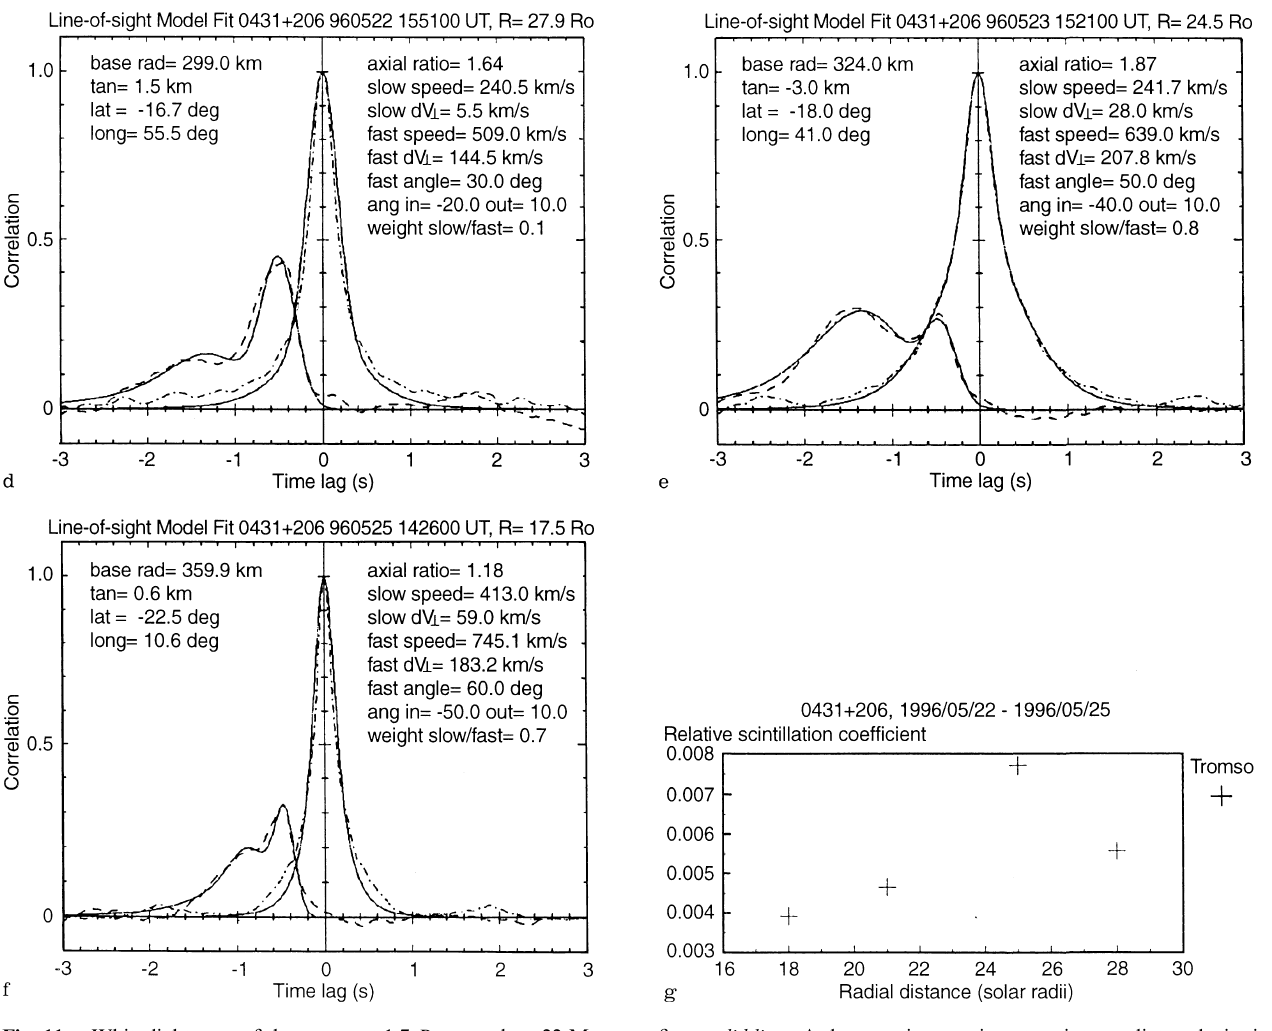
variation of the observed power divided by the mean